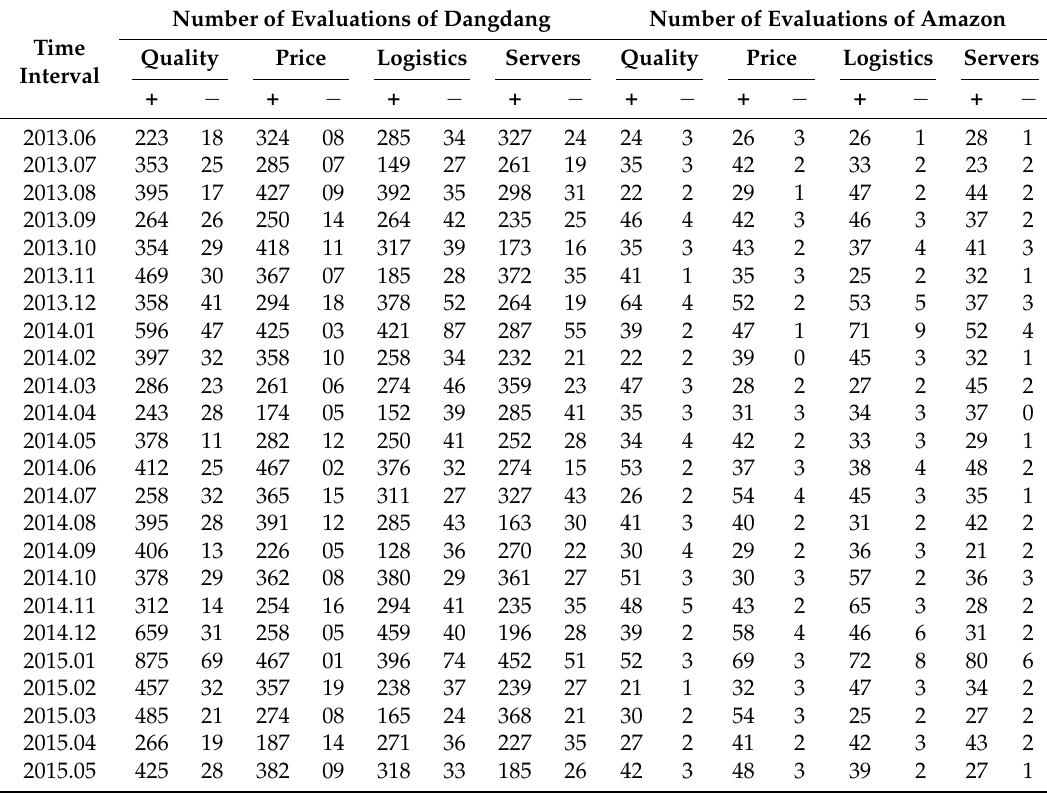
Figure 7. Dynamical reputation and trust for books on Amazon over 24 months. Table 5. Number of evaluations of trust in books on Dangdang and Amazon during the 24